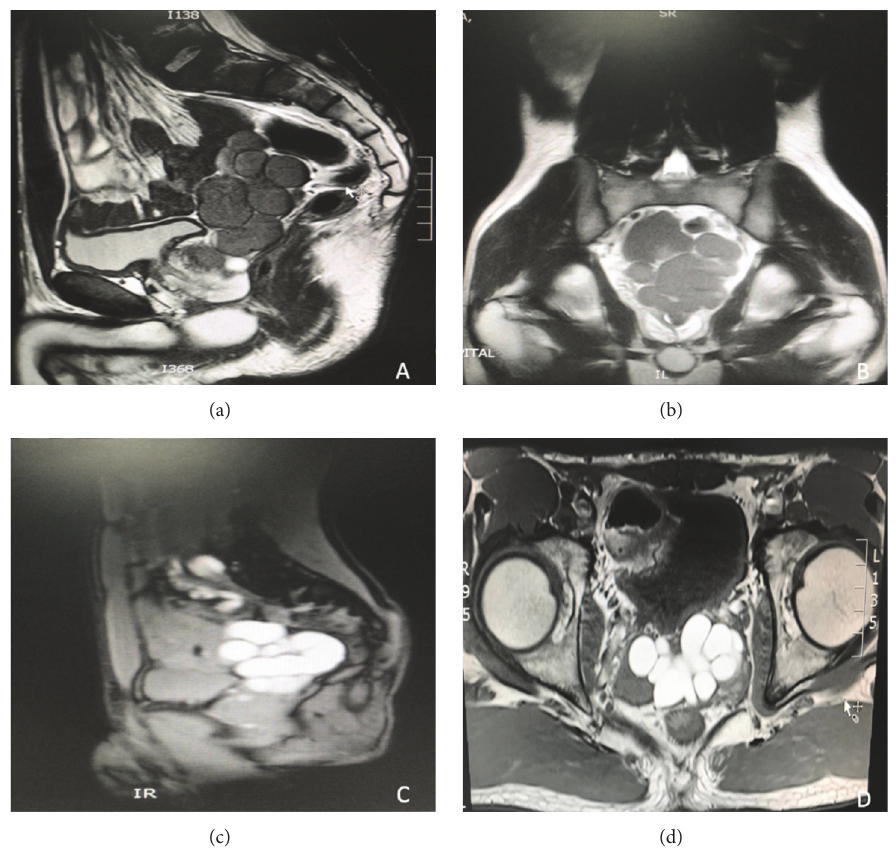
Figure 1: (a) MRI sagittal section T2, (b) MRI coronal section T2, (c) MRI sagittal section T1, and (d) MRI axial section T1. (a)-(b) showed diffuse dilatation of left seminal vesicles with low signal intensity, and (c)-(d) showed diffuse dilatation of left seminal vesicles with high signal intensity.